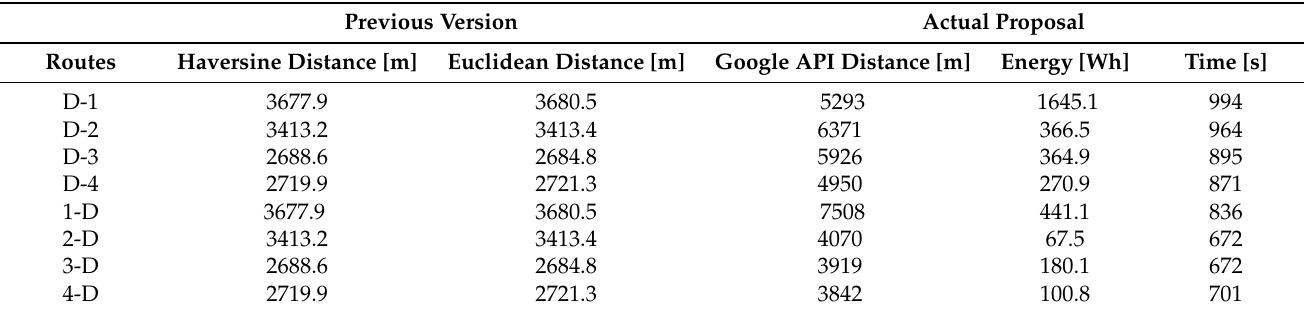
Table 3. Numeric results of supplier route deliveries for